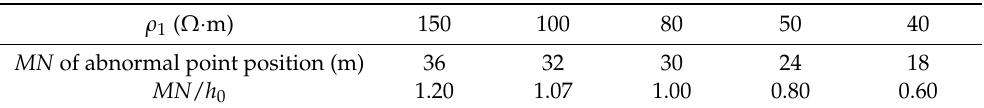
Table 2. Ratios of MN/h 0 at abnormal points of FSM sounding curve with different resistivity ρ 1 of sphere.